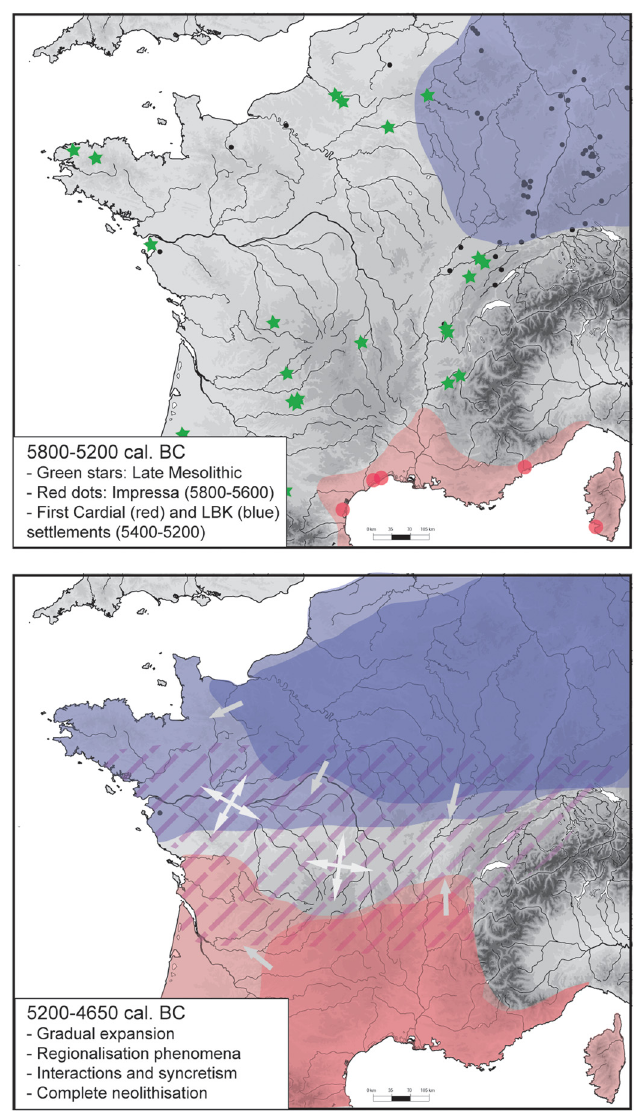
Figure 1: Schematic maps of the spatial and temporal dynamics of expansion of the fi rst farmers in France. In green: Late Mesolithic sites; in red: the Impressed Ware culture ( Impressa/Cardial and Epicardial facies ) which spread along the Mediterranean coastline; and in blue: the Linearbandkeramik culture ( also known as the LBK, Linear Ceramic or Rubané ) which spread throughout Continental Europe ( DAO: C. Manen )